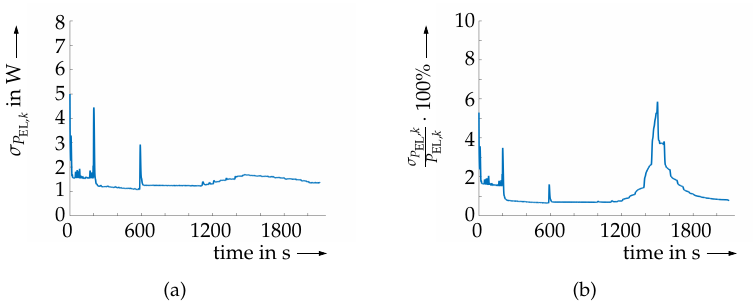
Figure 9. Quantification of the accuracy of the estimated electric fuel cell power. ( a ) Standard deviation of the estimated power. ( b ) Deviation of the estimated power in percent.